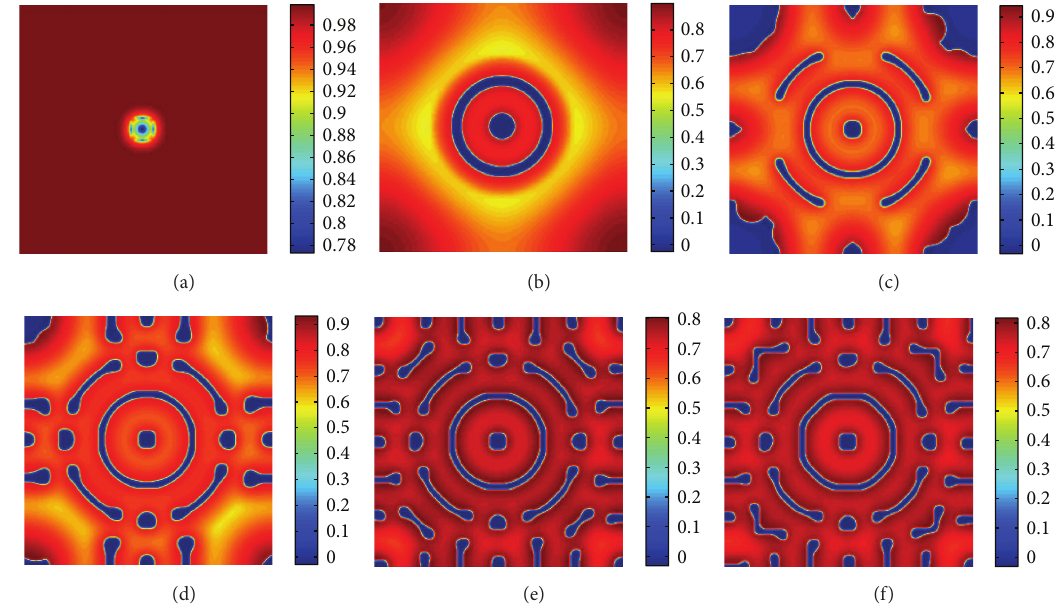
Figure 6: The process of pattern formation of prey 𝑢 in model (5) with 𝐷 12 = −0.5 ; other parameters are fixed as (27) in the text. Time steps: (a) 𝑡 = 10 ; (b) 𝑡 = 105 ; (c) 𝑡 = 151 ; (d) 𝑡 = 179 ; (e) 𝑡 = 300 ; and (f) 𝑡 = 1000